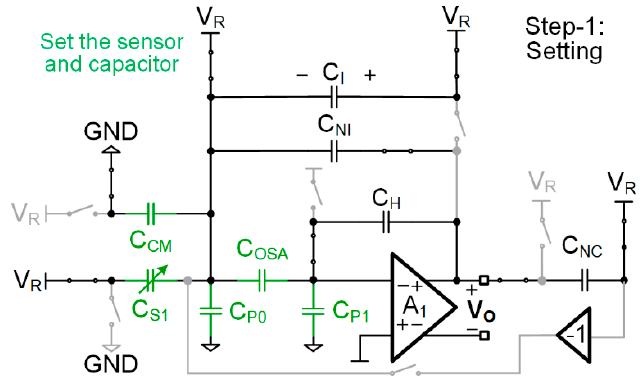
Figure 6. The setting phase of the reset noise sampling feedforward technique.